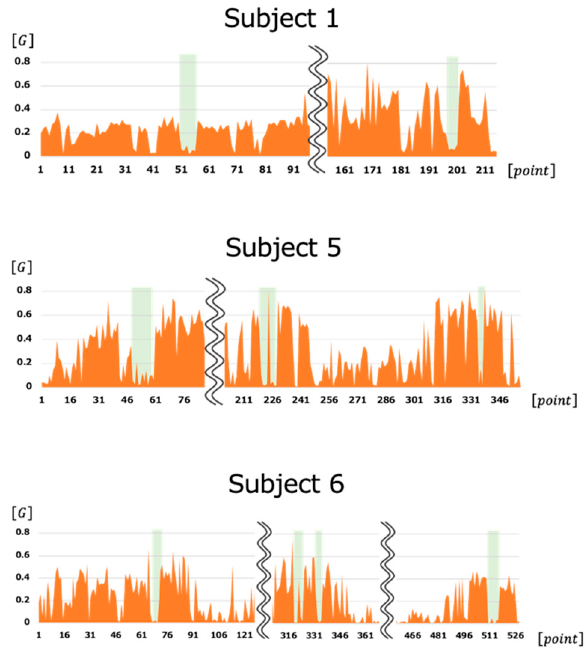
Figure 16. Experimental data of three cases with variations of acceleration sensors’ values. Light green areas indicate the durations corresponding to tangled trajectory lines when users were stopping outdoors, e.g., waiting for traffic signals.